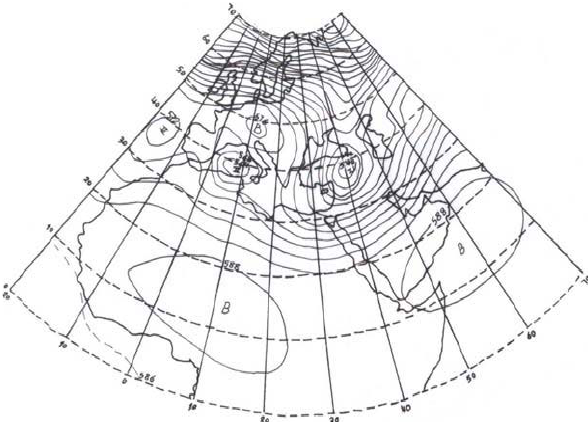
Fig. 5. The pattern of the geopotential heights at 500hPa after the rainfall (type I: 1 December 1986). Fig. 5 The pattern of the geopotential heights at 500 hPa after the rainfall (Type I: 1 December 1986)